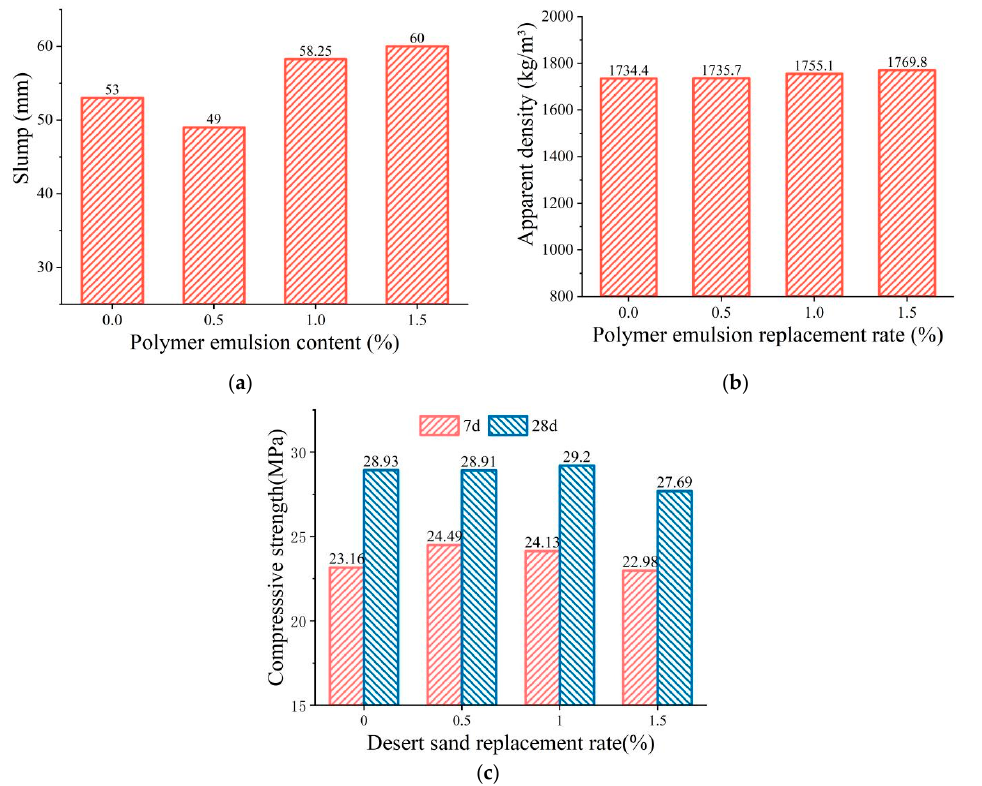
Figure 8. The relationship curve between PLE addition and FDCC performance: ( a ) slump; ( b ) apparent density; ( c ) compressive strength.